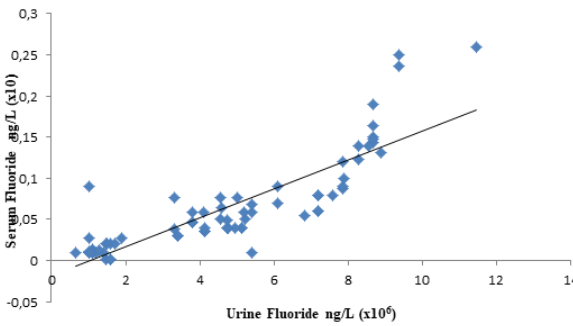
Figure 3: Relationship between Urine and Serum fluoride of RM Participants r =